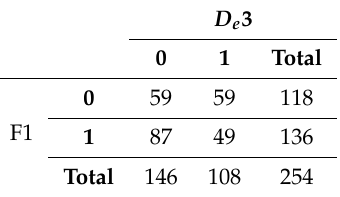
Table 6. Cross tabulation of variables F1 and D e 3, for respondents with K1 =